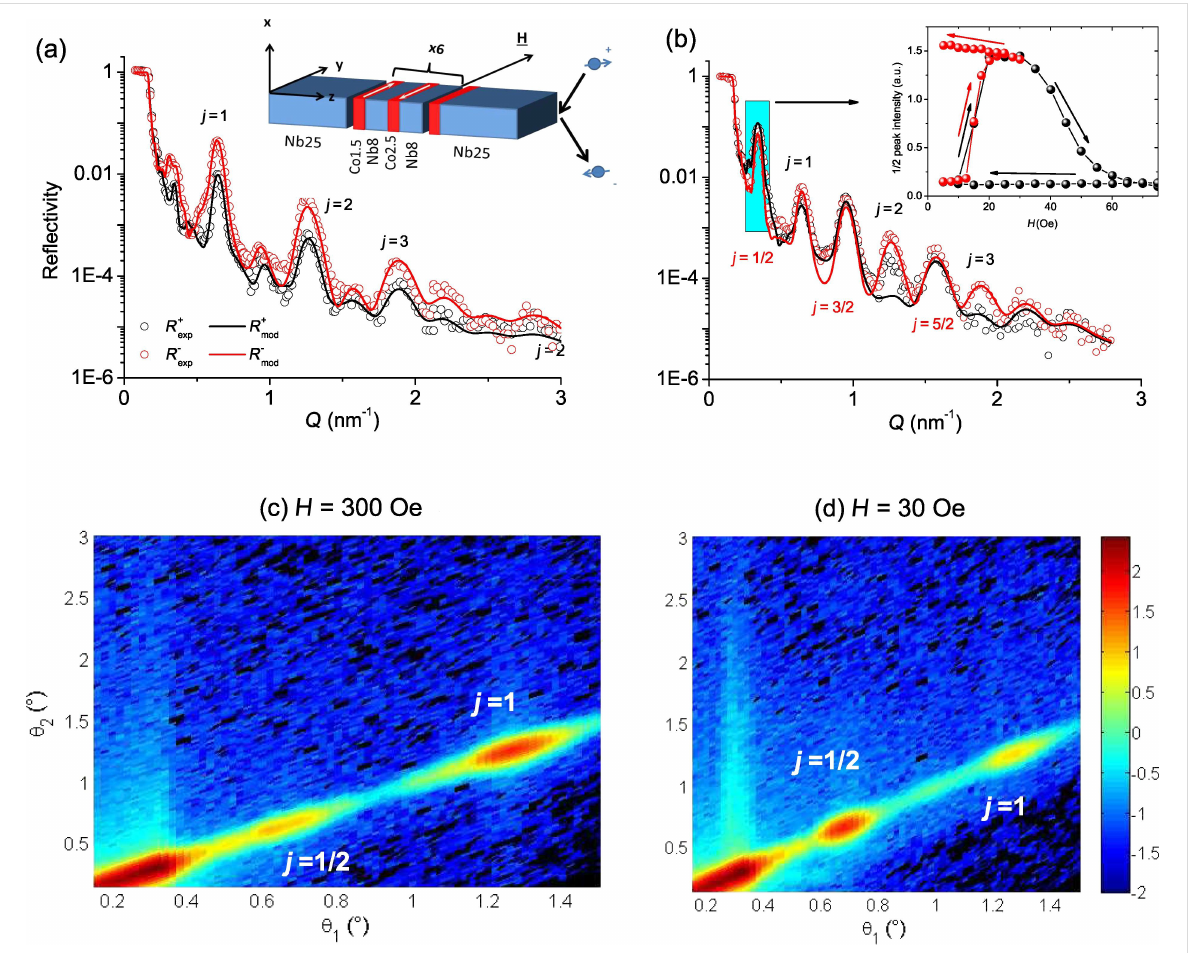
Figure 3: Experimental (dots) specular neutron reflectivity measured at T = 13 K in magnetic fields H = 300 Oe (a) and H = 30 Oe (b). Solid lines show the model curves for the magnetization depth profiles depicted in Figure 4a. The inset in (a) shows the sketch of the sample and experimental setup. The numbers above show the corresponding order of Bragg reflection from the effective [Co(2 nm)/Nb(8 nm)] × 12 periodic structure. The inset in (b) shows the field dependence of the j = 1/2 peak shown by the blue rectangle in (b). The logarithm of intensity of spin-down scattered neutrons measured at H = 300 Oe and H = 30 Oe is shown in (c) and (d).